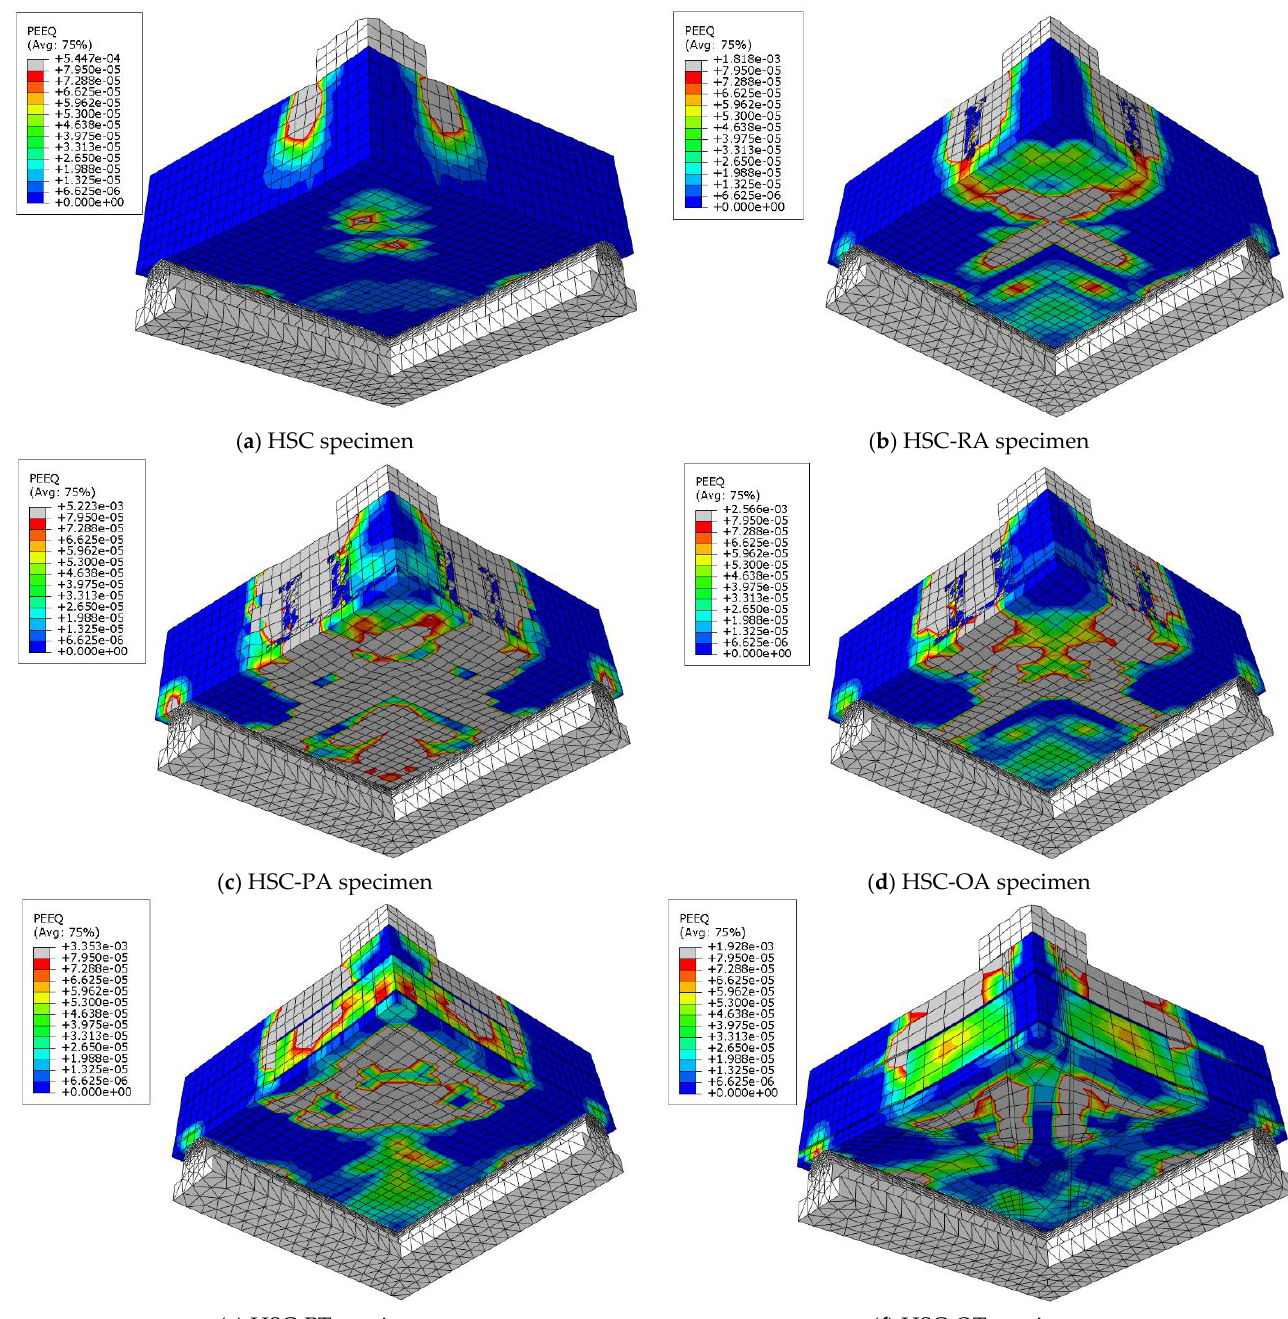
Figure 21. Analytical NC specimens cracks.